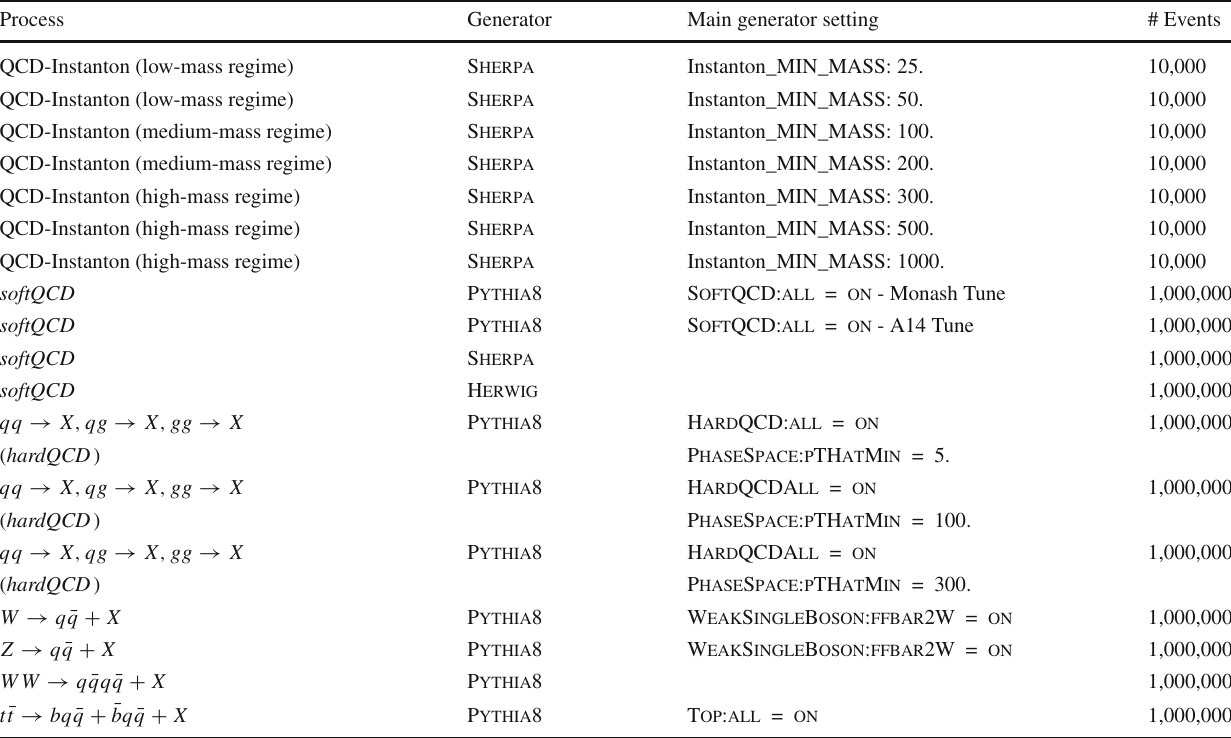
Table 2 Overview of the MC samples used to model the Instanton signal process and the SM background processes Process Generator Main generator